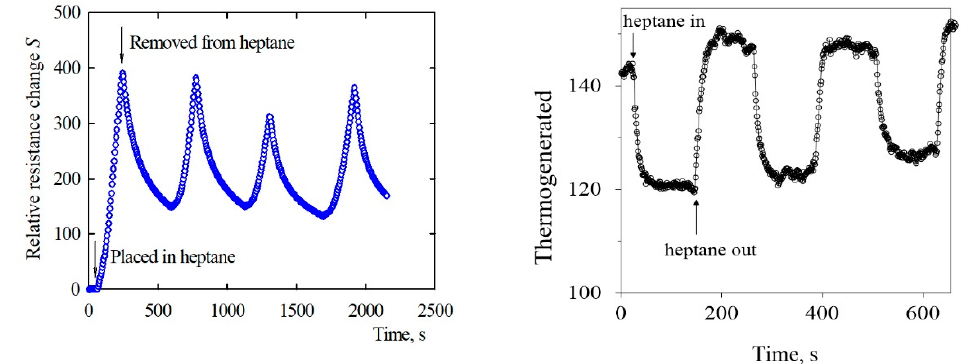
Figure 12. The time-dependent relative resistance change of the MWCNT(Sun)pristine/EOC composite (in %) during adsorption/desorption cycles of exposition to saturated vapors of heptane at 22 °C, the cycle length 600 s. The changes of the thermogenerated voltage induced by the self-powered vapor sensor in the course of three heptane adsorption and desorption cycles at 22 °C.